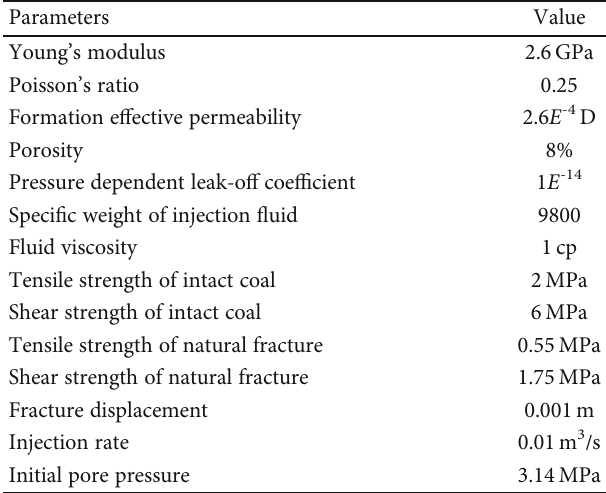
Figure 7: Simulation setup for reservoirs with two preexisting natural fracture sets. Table 3: Input parameters for simulating hydraulic fracture propagates in naturally fractured